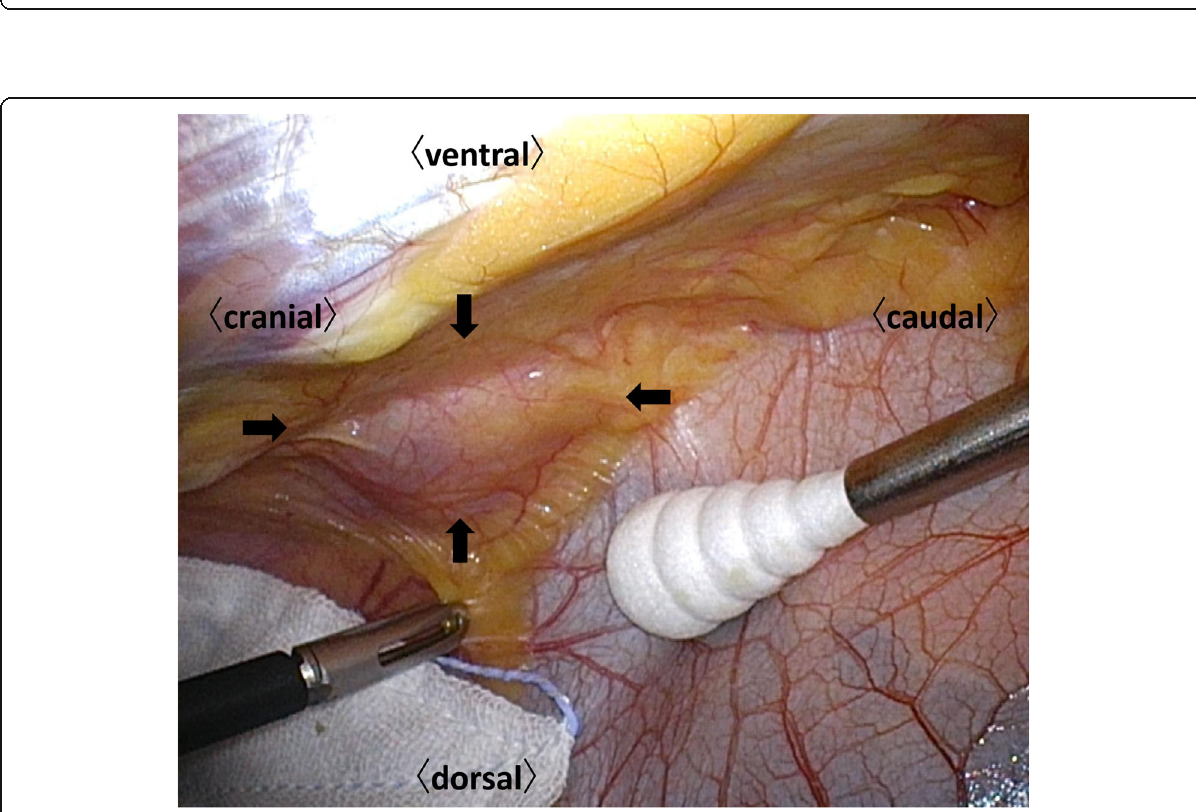
Fig. 4 A total thymectomy was performed by a bilateral approach via a video-assisted thoracoscopic surgery. The mass is enclosed by the arrows without any adhesions to the surrounding